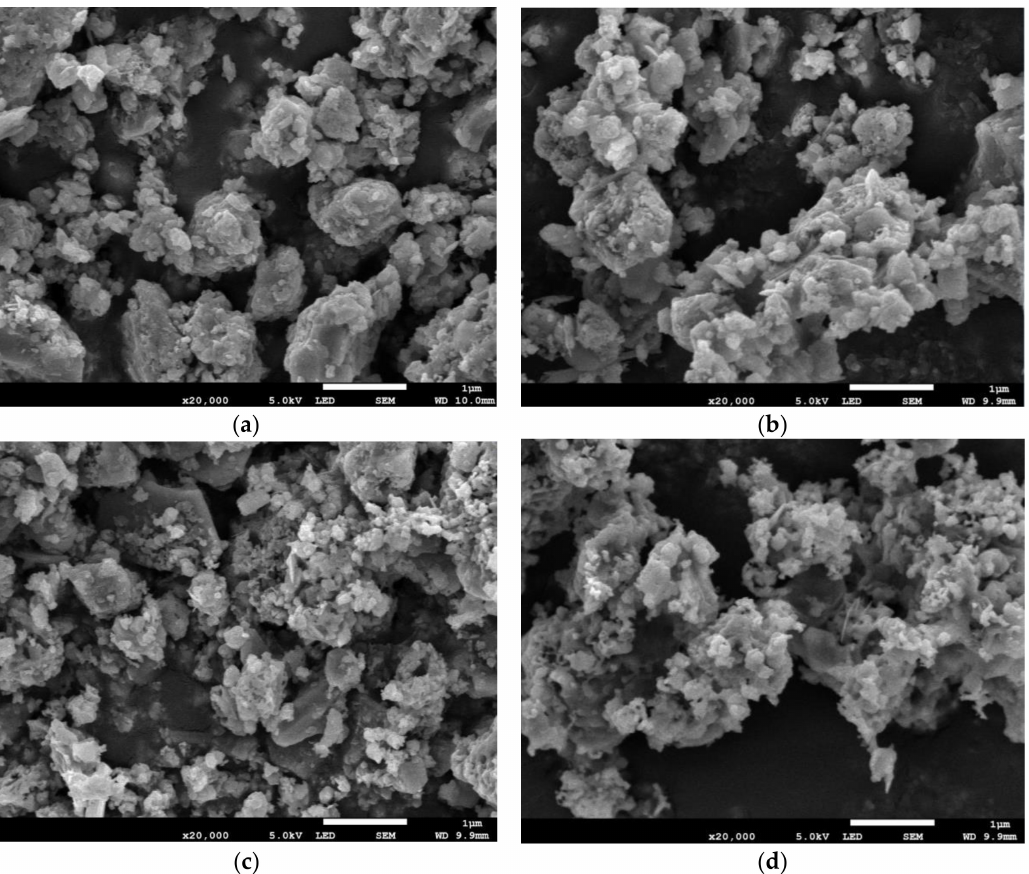
Figure 7. SEM detection for the microstructure with 20,000 times. ( a ) Original WCP, ( b ) WCP heated by 600 ◦ C, ( c ) WCP heated by 700 ◦ C, and ( d ) WCP heated by 800 ◦